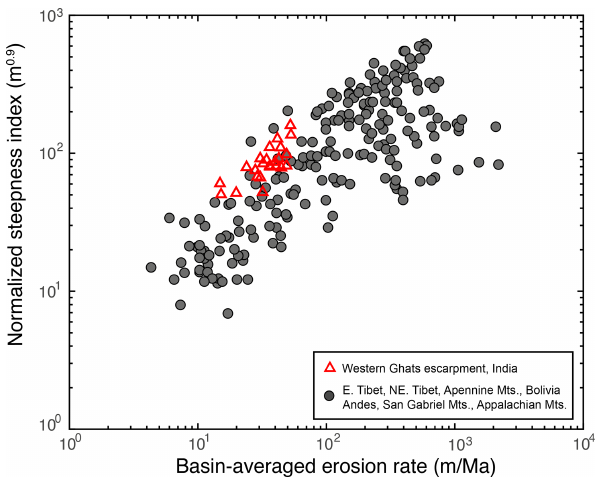
Figure 5. Normalized channel steepness index and cosmogenic 10 Be-derived basin-averaged erosion rates from the southern West- ern Ghats (red-lined triangles) with comparison to a compilation of global data by Kirby and Whipple (2012) (gray dots). The steepness of Western Ghats rivers is from slope–area analysis using a uniform concavity of 0.45 to be consistent with the global